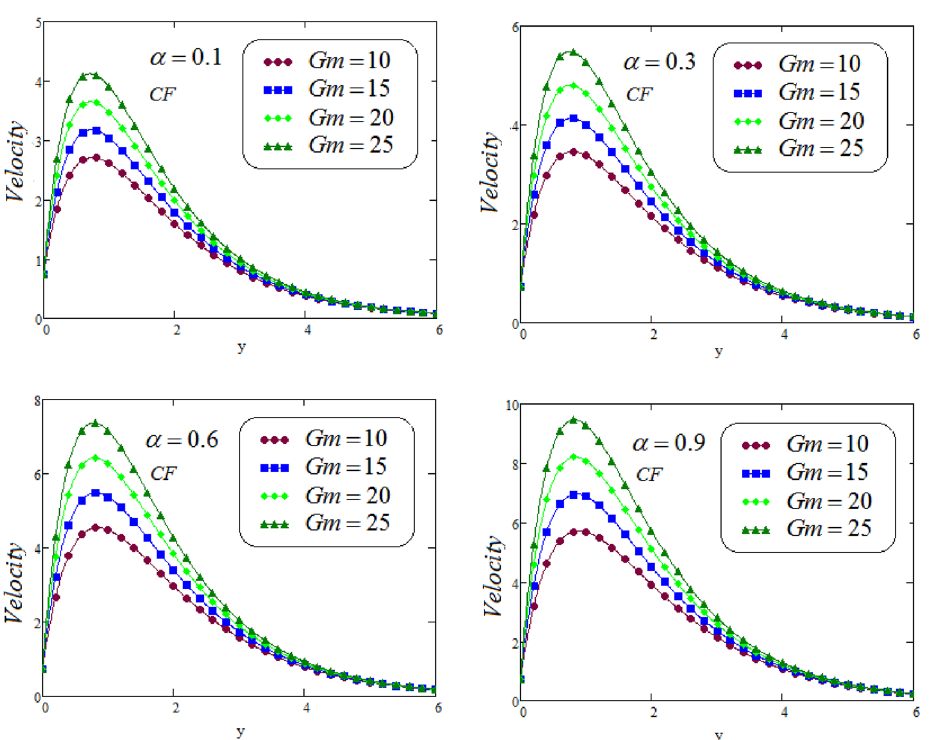
Figure 6. Representation of second grade fluid velocity via CF for distinct values of Gm